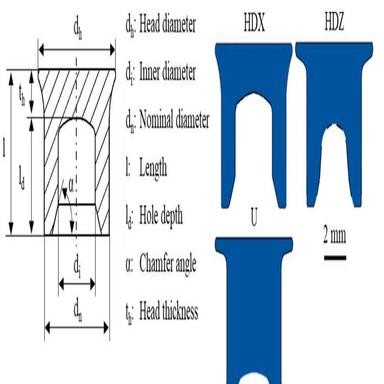
Characteristic rivet geometry parameters and rivet geometries used for the study.